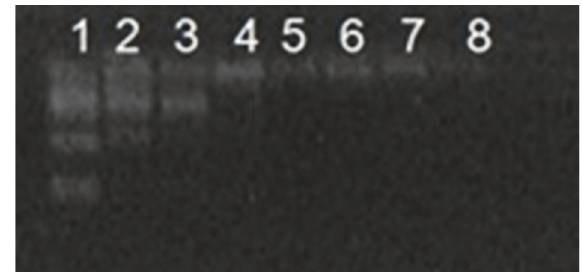
Figure 1: Electrophoretic mobility of pmPPY-pSox9 nanoparticles at various ratios: Lane1: Free plasmid Sox9; Lane (2-8): pmPPY/pSox9 nanoparticles in ratios of 3:1, 9:1, 15:1, 50:1, 100:1, 150:1, and